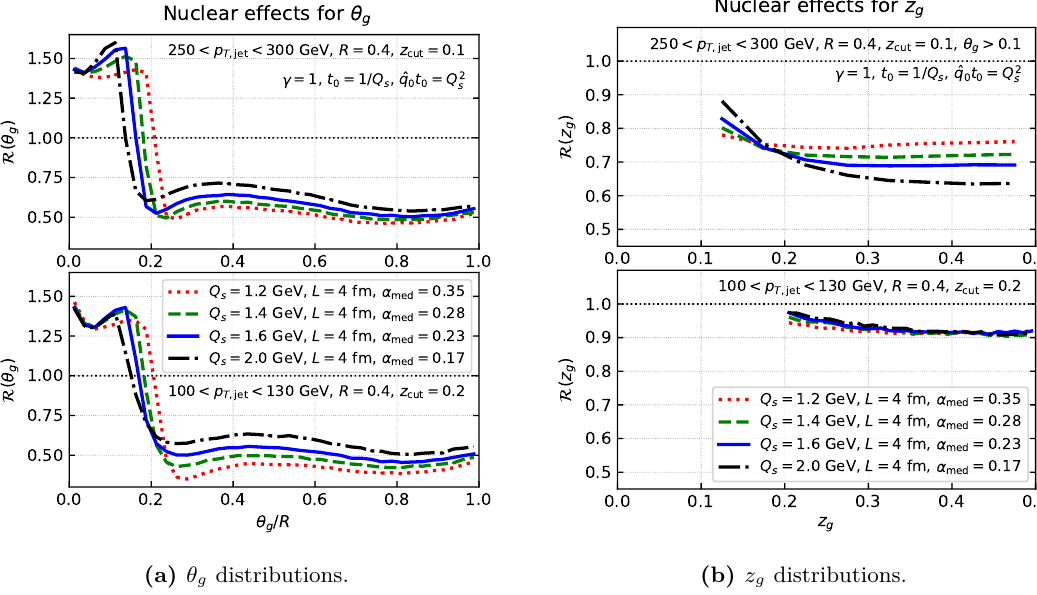
Figure 7. Monte-Carlo simulations of the nuclear modification factor for distributions after Soft Drop: (a) the groomed jet radius θ g and (b) the momentum fraction z g . The Soft Drop param- eter β is set to β = 0 . For both distributions, the upper panel corresponds to z cut = 0 . 1 and 250 < p T, jet < 300 GeV, whereas the lower panel has z cut = 0 . 2 and 100 < p T, jet < 130 GeV. As in the ALICE [64] and CMS measurements [65], an additional angular cut-off θ g > 0 . 1 is imposed for the z g distribution calculated with z cut = 0 . 1 . We use the same sets of values for the medium parameters as in figures 5b–6b (cf. table